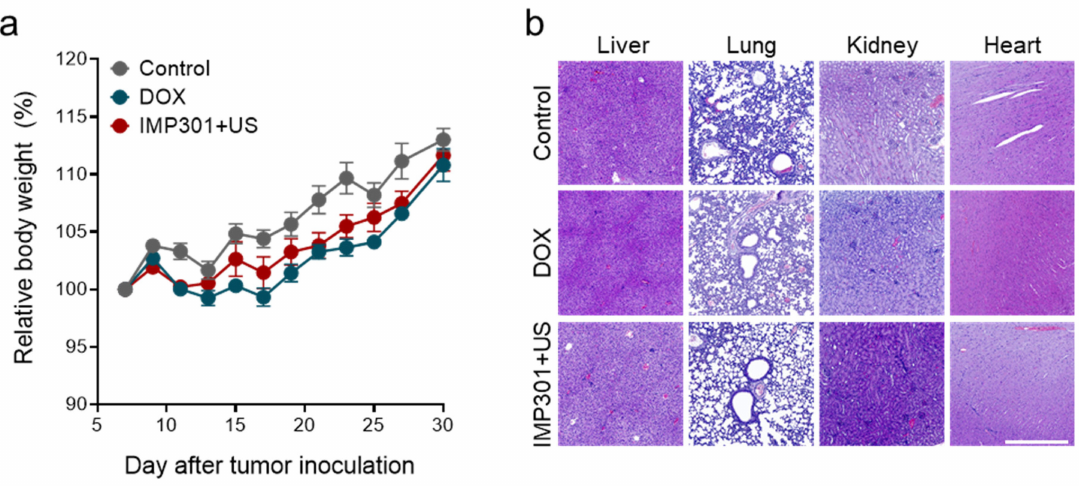
Figure 4. In vivo toxicity of the combination of IMP301+US. ( a ) Changes in body weight and ( b ) H&E-stained liver, lung, kidney, and heart tissues. Scale bar represents 500 µ m.